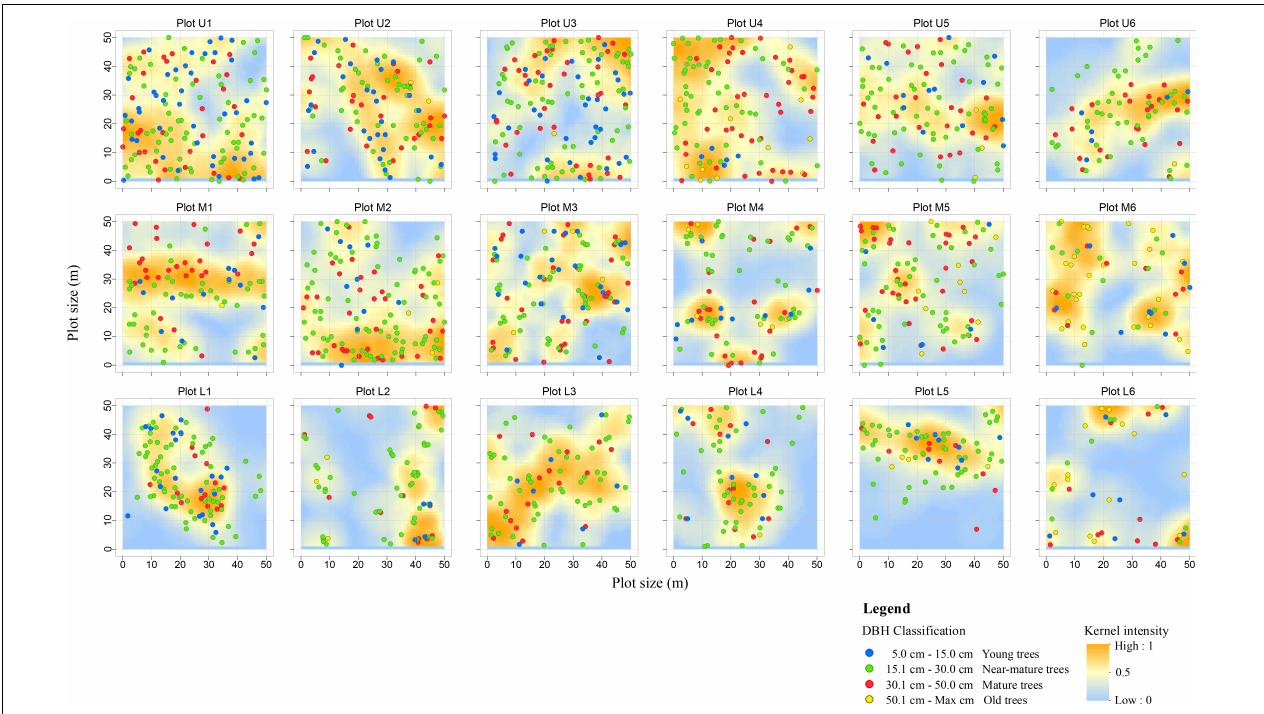
FIGURE 5 | Spatial distribution of P. euphratica trees at each (50 m × 50 m) plot within four DBH classes in the 18 plots. The first column (Plot U1–U6) represented the upper reaches, the second column (Plot M1–M6) represented the middle reaches, and the third column (Plot L1–L6) represented lower reaches plots. Every point of a different color indicates the position of individual trees at a different DBH class. The change of background color indicates kernel intensity map. The deep yellow indicates a highly concentrated area; the pale yellow indicates a scattered area; and the blue indicates a low concentrated area.